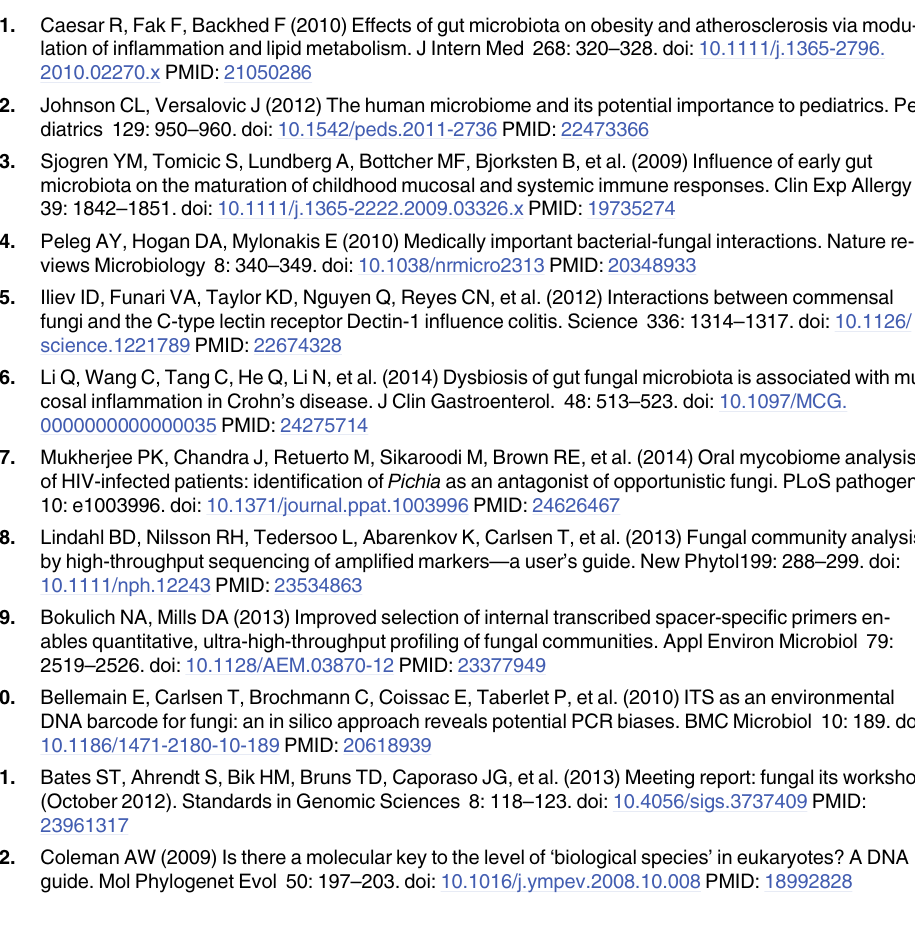
S2 Table. Complete taxonomic compositions (given as percentages of sequence reads) from